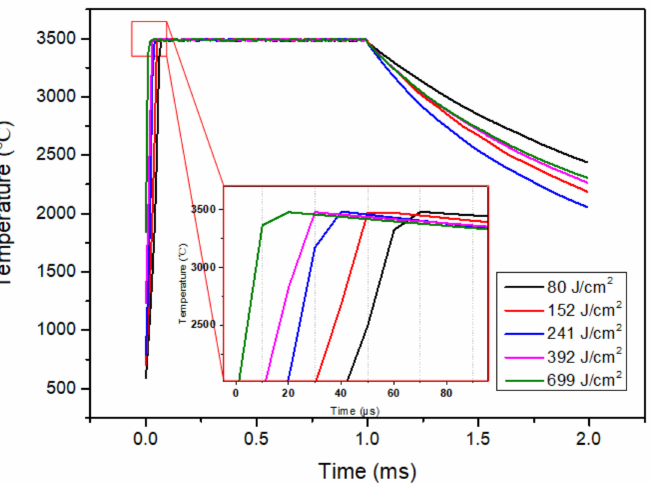
Figure 4. Under the condition of single pulse, the surface temperature of laser damaged CFRP changes with time. (d = 1 mm, τ p = 1